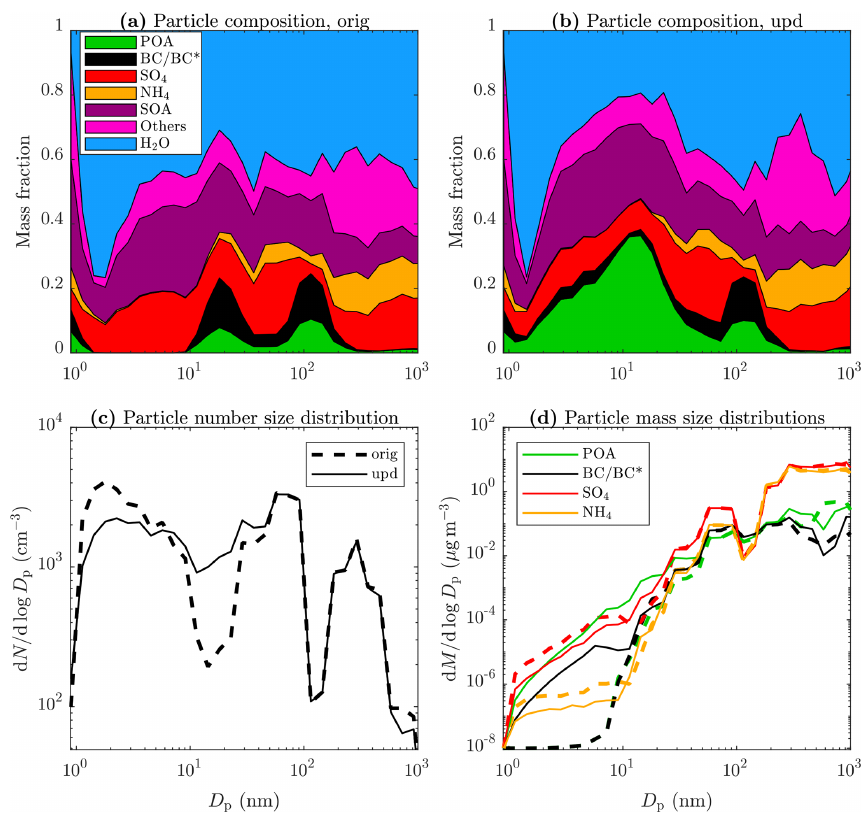
Figure 7. Simulated particle composition in Melpitz, on 24 May 2008 at 09:00-10:00LT, using (a) the original and (b) the updated emission inventory and simulated particle (c) number and (d) mass size distributions using the original and the updated emission inventory. Others denote the sum of the remaining components, i.e., crustal material, nitrate, sodium, chloride, and the surrogate amine